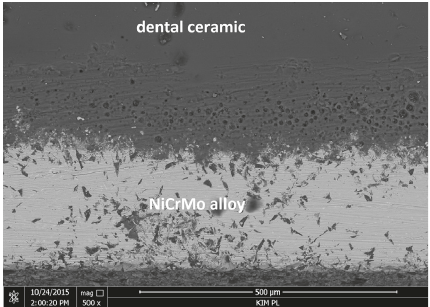
Figure 2: Lateral view of the metal-ceramic bond surface (speci- men 100): porosity in dental porcelain (SEM